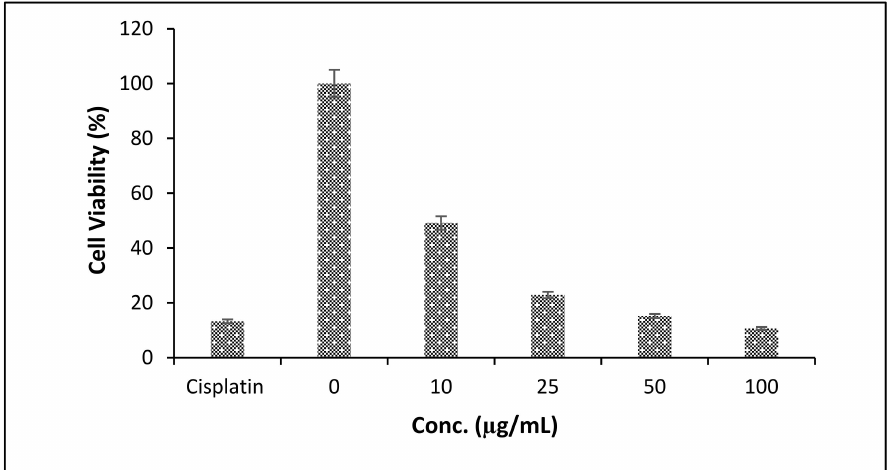
Figure 11. Anticancer potential of untreated control, cisplatin, and silver nanoparticles at different concentrations against